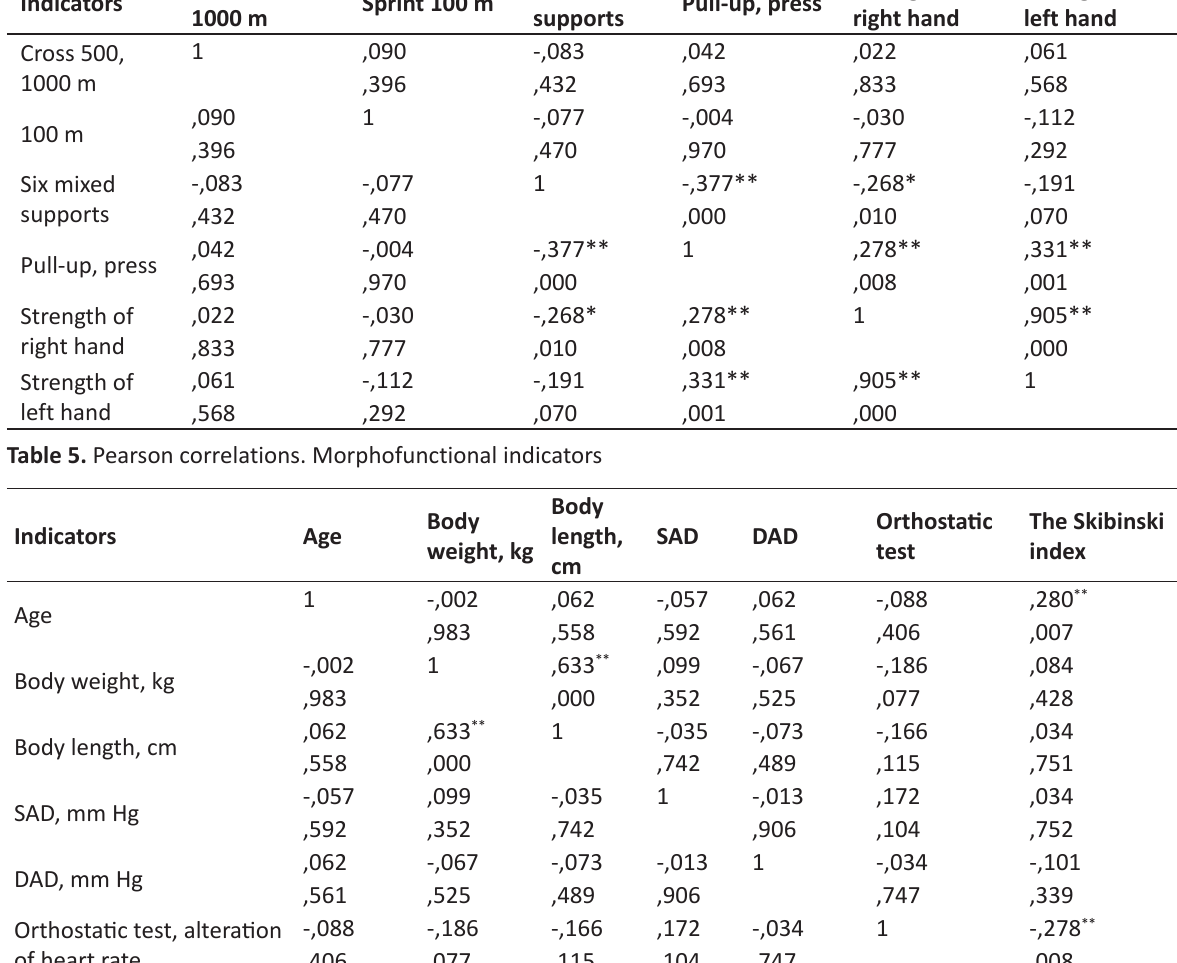
Table 4. Pearson correlations. Physical fitness Indicators